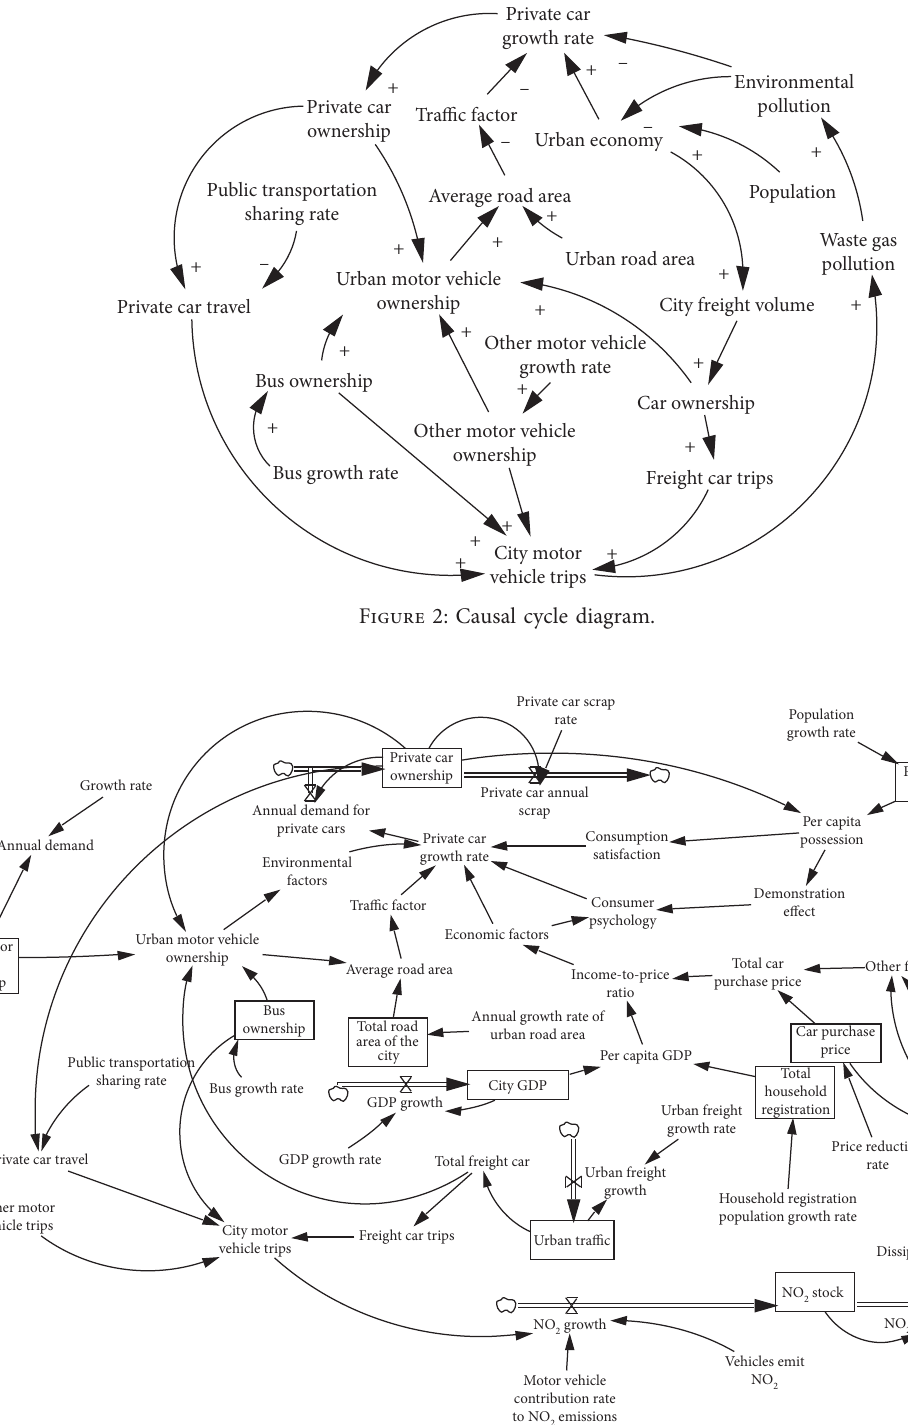
Figure 3: System dynamics diagram (without